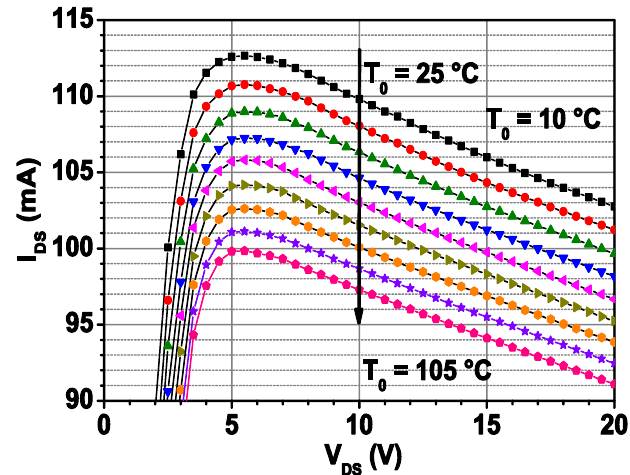
Figure 3. Output I-V characteristics for V GS = 0 V at various T 0.